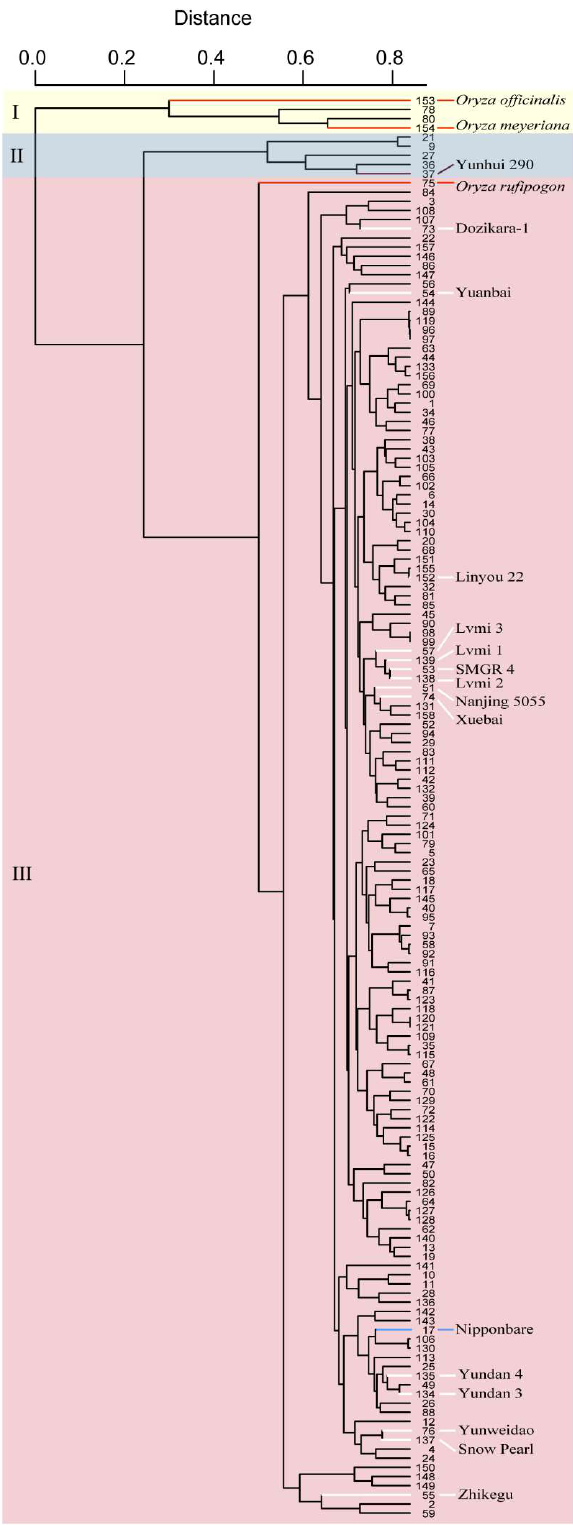
Figure 2. The cluster results of the local rice varieties in Yunnan based on SNP genotypes at the whole-genome level. Groups I, II and III are indicated with a light yellow, light blue and light red background, respectively. Varieties indicated with red and white lines are the wild rice accessions and introduced varieties, respectively. The control variety Nipponbare is indicated with a blue line. Yunhui 290, a classical indica inbred variety, is indicated with a purple